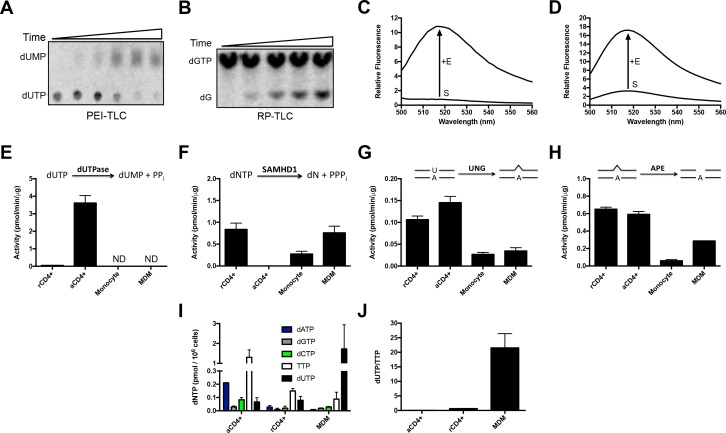
Profiling enzyme activities and dNTP pool levels in immune target cells of HIV.Extracts from each indicated cell type were obtained as described in Methods. (A) Deoxyuridinetriphosphate hydrolase (dUTPase) activity was measured by monitoring the hydrolysis of dUTP to dUMP via PEI-cellulose TLC. Specificity was determined using a potent dUTPase inhibitor [compound 26 in Priet et al. (2005)]. (B) SAMHD1 triphosphohydrolase activity was determined by C18 RP-TLC-based assay using 8-3H-labeled dGTP as the substrate. Specificity for SAMHD1 was determined using the inhibitor pppCH2dU. The mobilities of the substrate (dGTP) and product nucleoside (dG) are marked. (C) Endogenous uracil DNA glycosylase (hUNG) activity (combined hUNG1 and hUNG2) was determined using a fluorescein-labeled DNA substrate that shows an increase in fluorescence upon uracil excision. Specificity for hUNG activity was determined by addition of the uracil DNA glycosylase inhibitor protein (UGI). (D) Apyrimidinic endonuclease (APE1 or 2) activity was measured using a fluorescein-labeled duplex DNA containing a single abasic site that increases in fluorescence upon endonuclease cleavage. (E) dUTPase activity. (F) SAMHD1 activity. (G) hUNG activity. (H) APE activity. (I) Measurement of deoxyribonucleotide (dNTP) pool levels were determined by an LC-MS method. (J) MDMs contain a high ratio of dUTP/TTP ratio compared to resting and activated CD4+ T cells. Abbreviations: rCD4+, resting CD4+ T cell; aCD4+, PHA activated CD4+ T cell; MDM, monocyte-derived macrophage. See Supplemental Methods for further details and references describing these assays. Number of experimental replicates (n = 3) and errors are reported as mean ± SD.